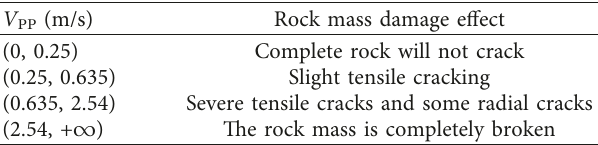
Table 2: Rock damage effect under different V PP